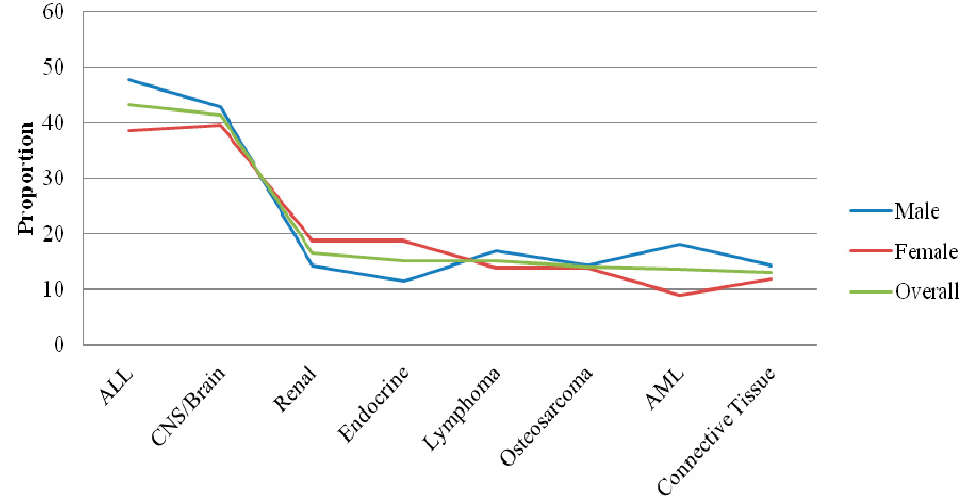
Figure 3. Cumulative Incidence for Childhood Cancer by Sex, Delaware 2004–2014.